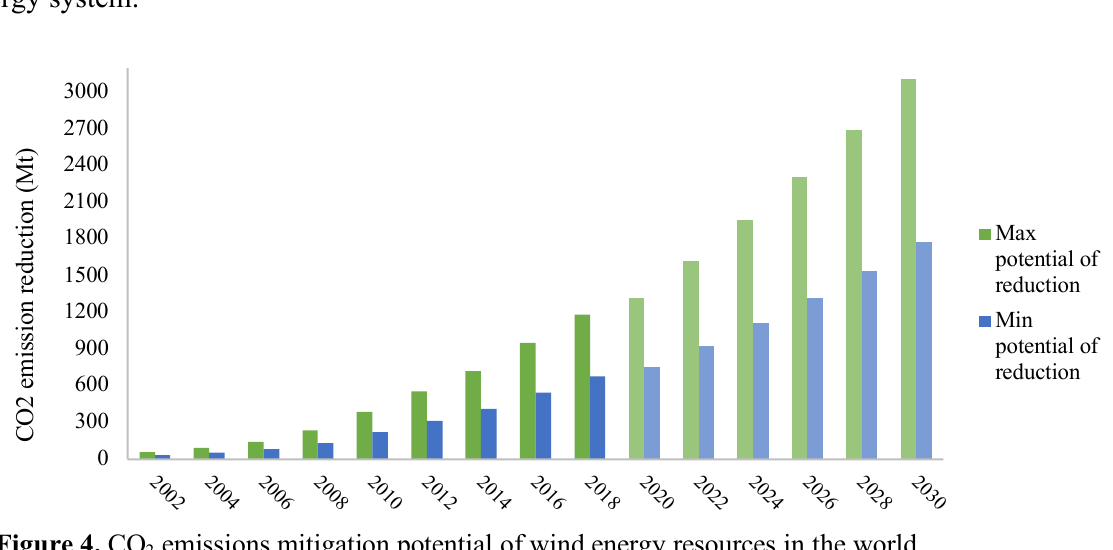
Table 1. Estimated CO